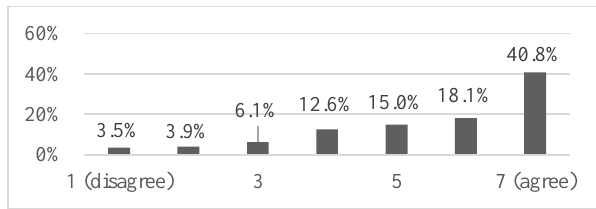
Figure 12 . Got help from